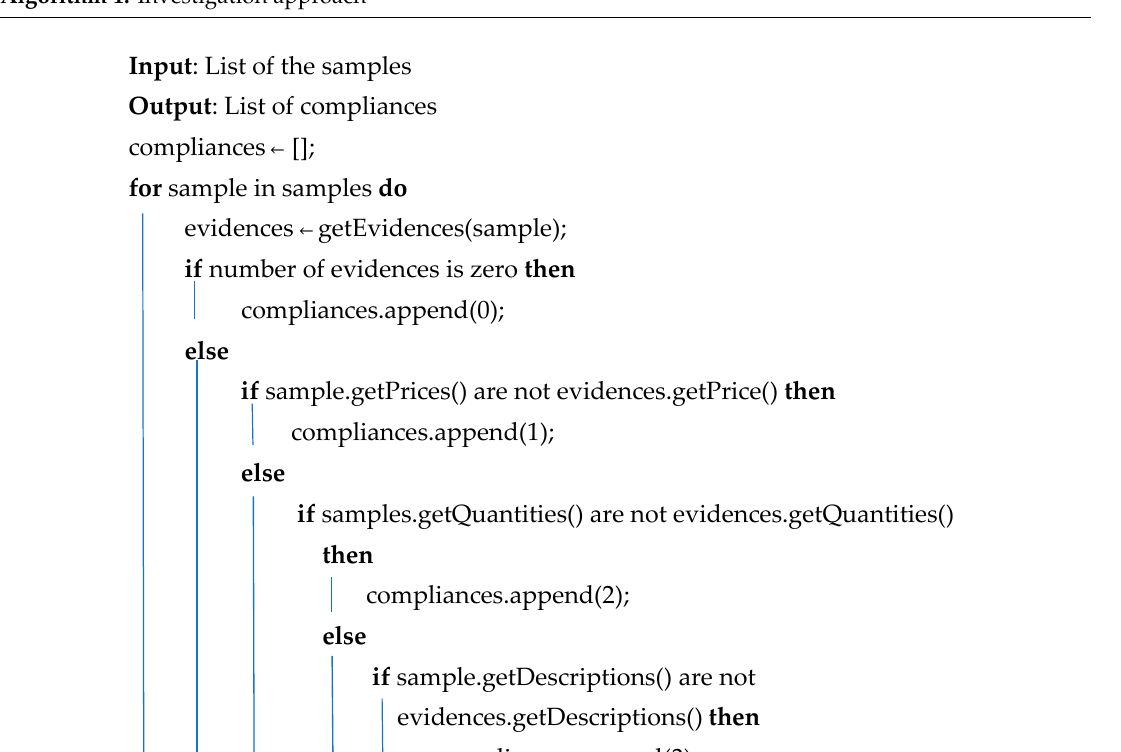
Algorithm 1: Investigation approach